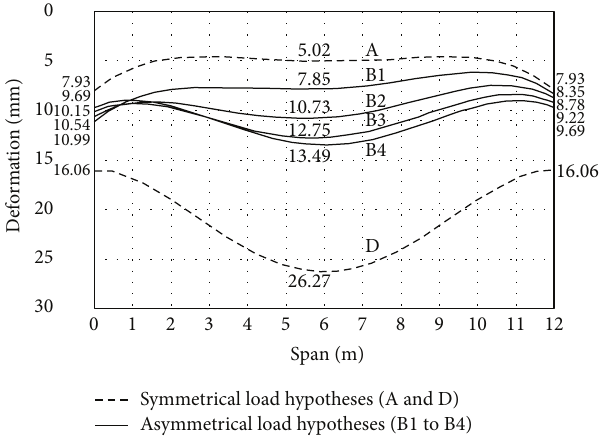
Figure 9: Deformation hypotheses (A), (B1), (B2), (B3), (B4), and (D), F1 structural floor type, section (S2).